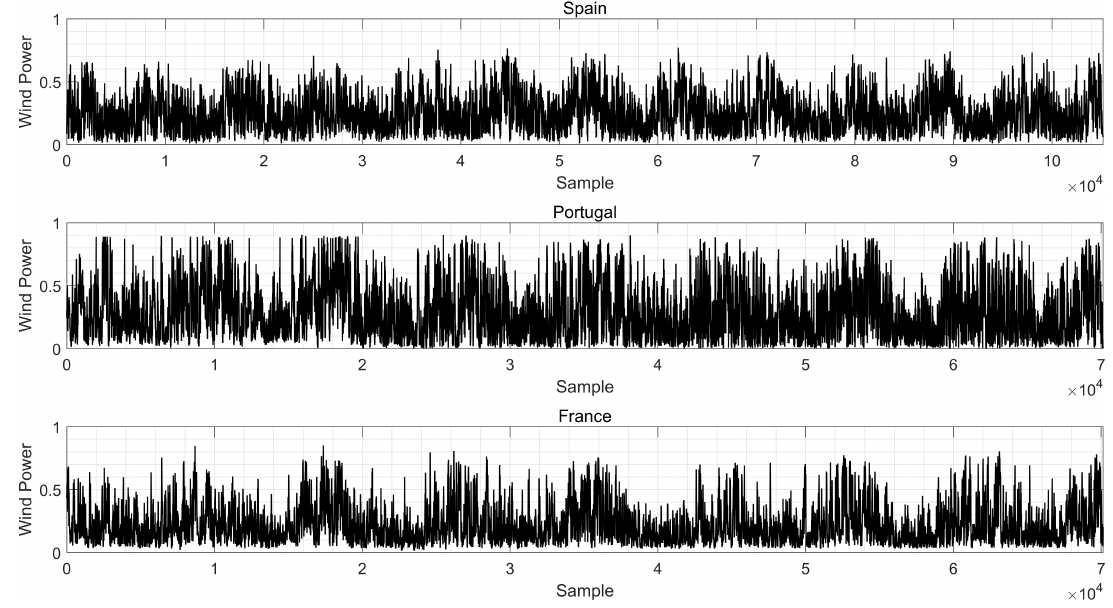
Figure 2. Historical data series.